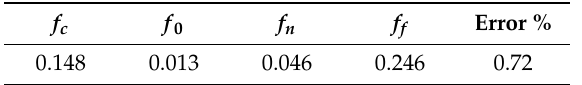
Table 2. The constants of GTN damage model obtained using polynomial regression